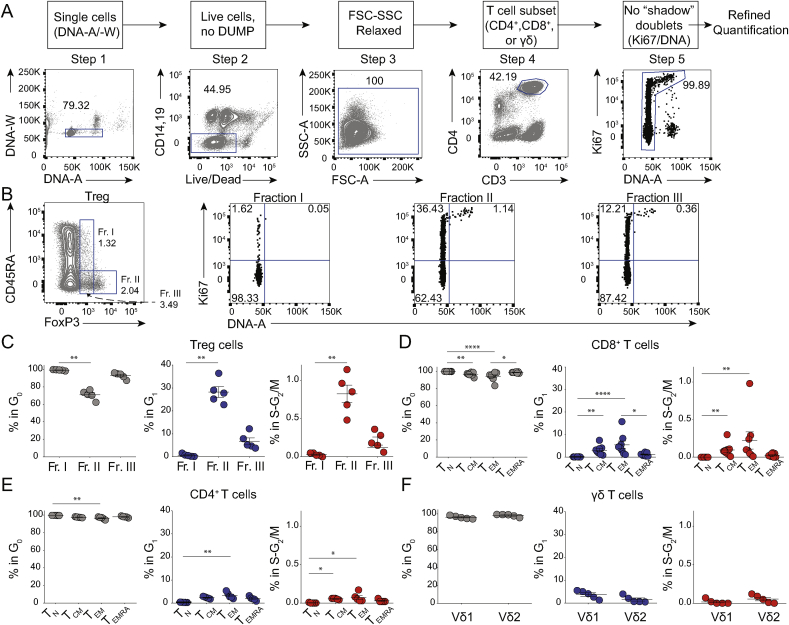
Some T cells in HD PBMC are in S-G2/M phases.A) Gating strategy (top) and example of CD4+ T cell flow cytometry analysis (lower). B) Refined quantification of Treg Fractions I, II and III among CD4+ T cells gated as in A, Step 1 to 5, (left), with illustrative examples of cells in G0, G1, and S-G2/M as assessed by Ki67/DNA profiles. Numbers represent cell percentages in the indicated gate. C–F) summary of refined cell cycle analysis of Treg Fractions (C), of TN, TCM, TEM and TEMRA among either CD8+ (D), or conventional CD4+ T cells (E), and of Vδ1 and Vδ2 among γδ T cells (F). (N = 7 experiments with a total of 12 HD). Statistical analysis performed using Friedman's test with Dunn's multiple comparison tests (C-E), and Wilcoxon test (F).